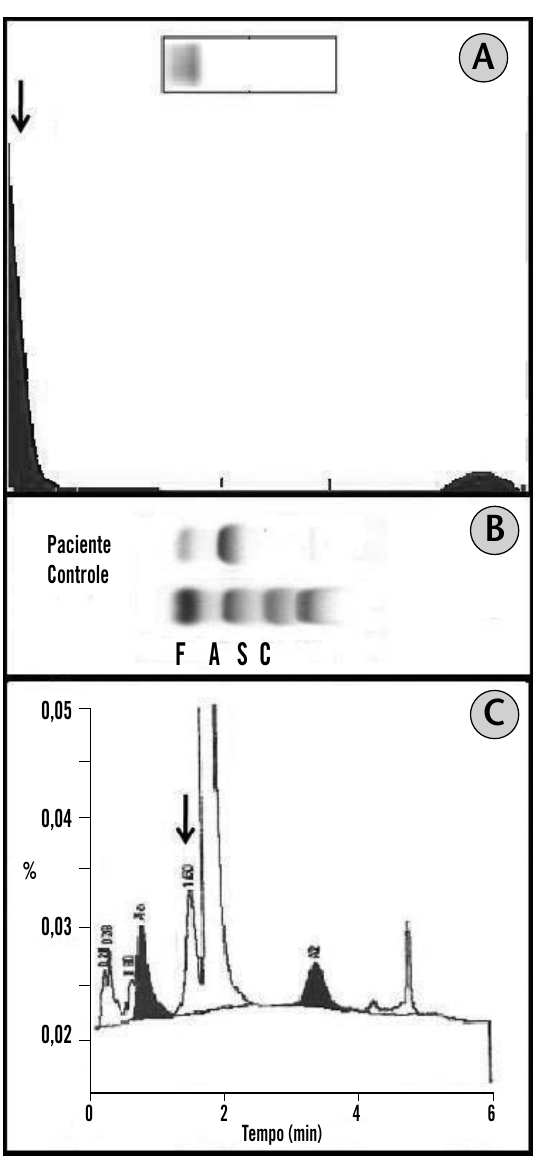
Figura 1 – (A) Eletroforese de Hb em meio alcalino, acompanhada de leitura densi- tométrica: HbV posicionando-se anteriormente à HbA, em posição de Hb “rápida” (seta); (B) eletroforese de Hb em meio ácido mostra a fração de HbV sobreposta à HbA; (C) HPLC indicando uma HbV com tempo de retenção de 1,60 minutos (seta) Hb: hemoglobina; HPLC: cromatografia líquida de alta